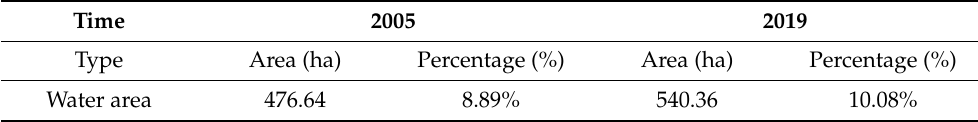
Table 1. Analysis of land use changes from 2005 to 2019.